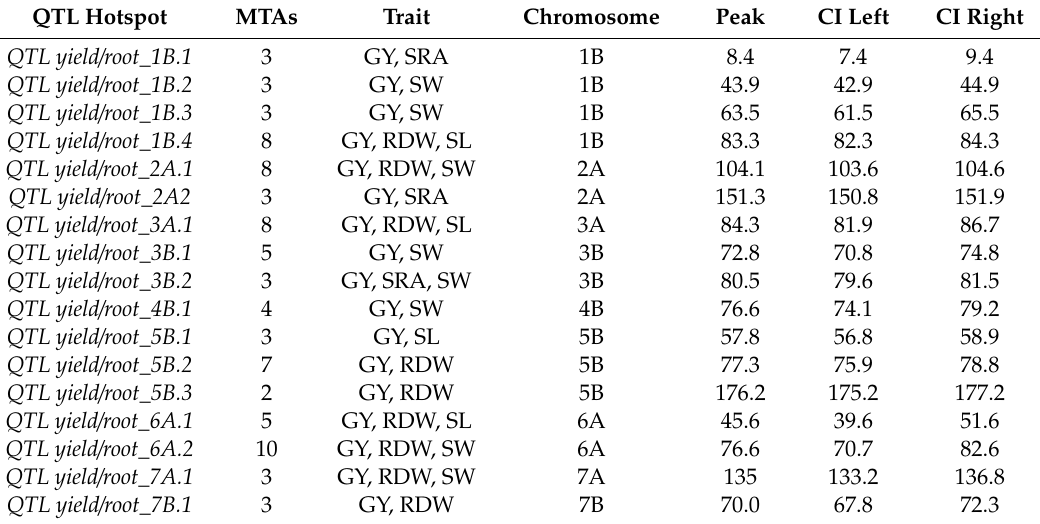
Table 6. QTL hotspots including grain yield. Positions are indicated in